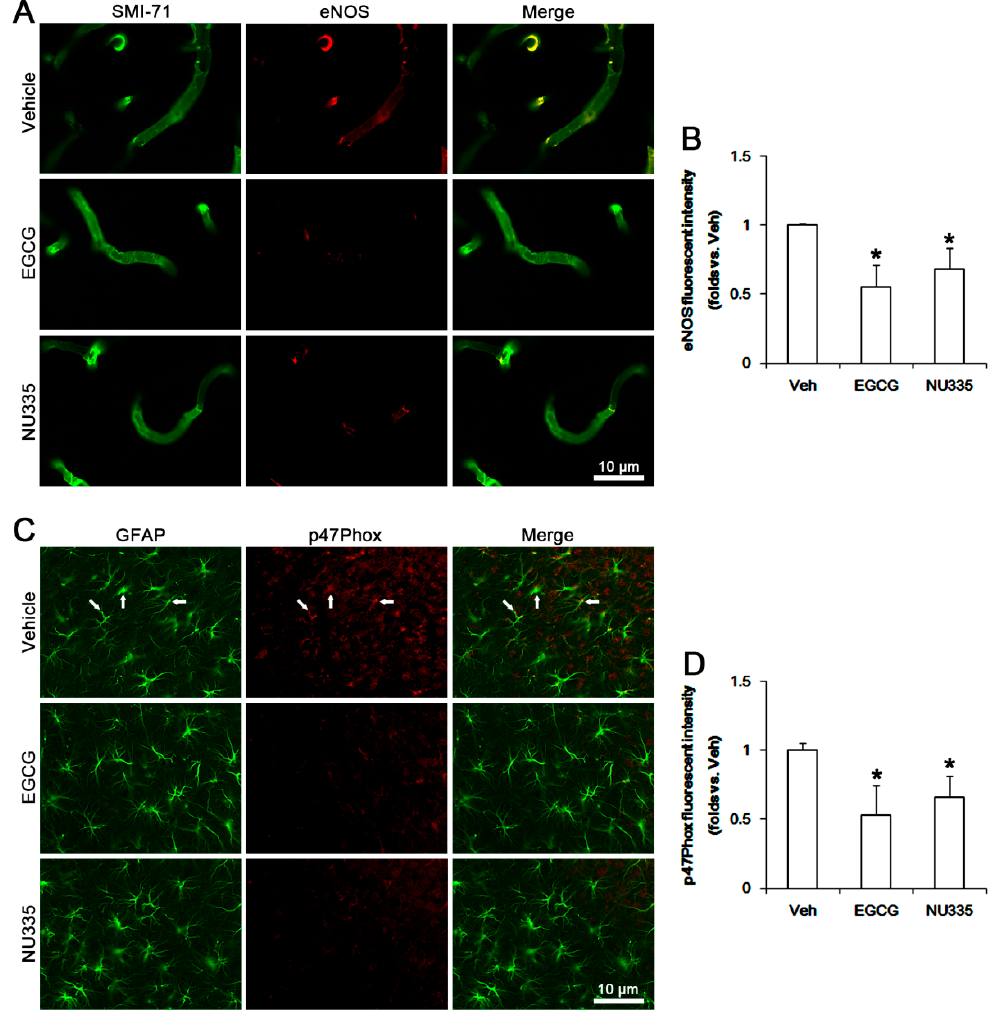
Figure 9. Effects of EGCG and NU335 on eNOS and p47Phox levels in the PC under physiological condition. eNOS signals are detected in endothelial cells. P47Phox expressions are observed in neurons and astrocytes (arrows, upper panels in C). EGCG and NU335 abolish eNOS and p47Phox expressions in endothelial cells and astrocytes, respectively. ( A ) Representative images for eNOS signals in the PC. ( B ) Quantification of the effect of EGCG and NU335 on eNOS fluorescent intensity ( n = 7, respectively). Error bars indicate S.E.M. Significant differences are * p < 0.05 vs. vehicle-treated animals. ( C ) Representative images for astroglial p47Phox signals in the PC. ( D ) Quantification of the effect of EGCG and NU335 on p47Phox fluorescent intensity ( n = 7, respectively). Error bars indicate S.E.M. Significant differences are * p < 0.05 vs. vehicle-treated animals.